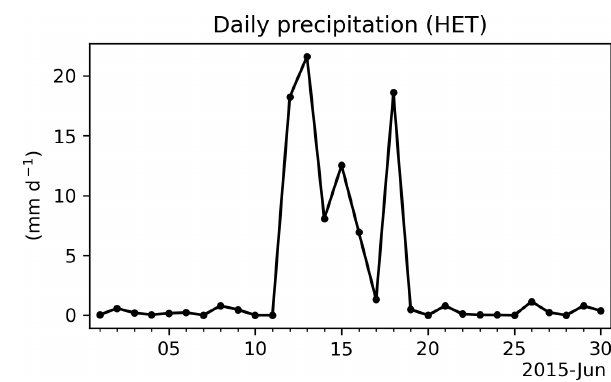
Figure 13. Frequency of occurrence of total precipitation from HOM and HET SCM simulations during the period of the precipi- tating days.